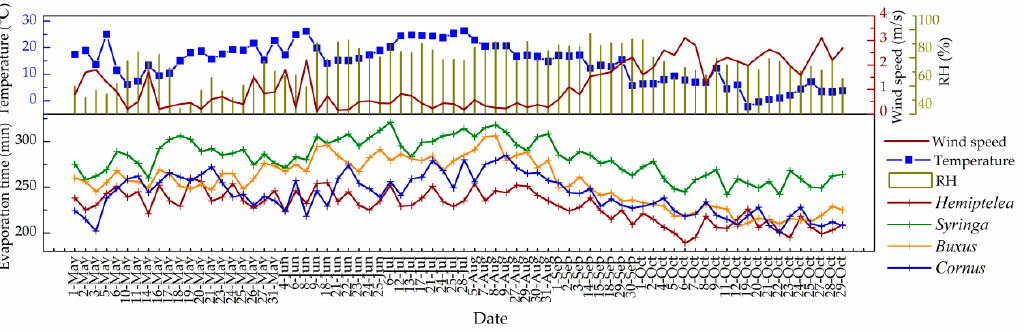
Figure 1. Meteorological factors in the study area and evaporation periods of different